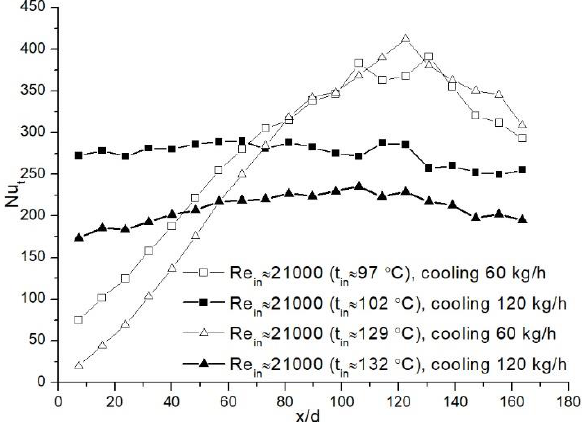
Figure 7. Comparison of the local Nu t distribution in the heat exchanger at Re in ≈ 21,000, different flue gas inlet temperatures and cooling water flow rates.